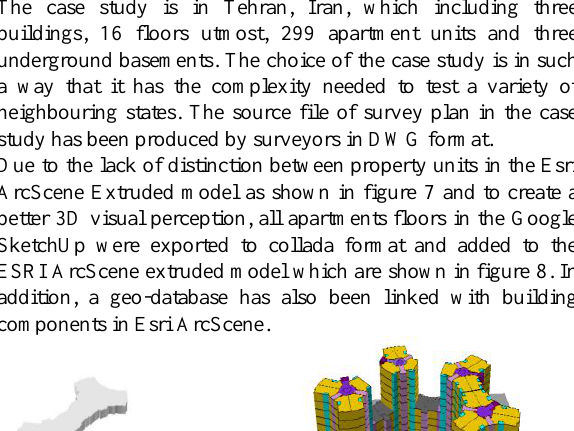
Figure 8. Esri ArcScene Model by Figure 7. Esri